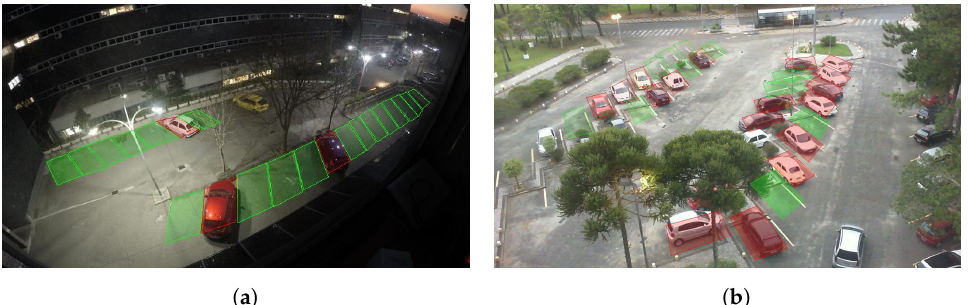
Figure 7. A sample of predictions obtained with the proposed multi-branch output system for two different datasets with different illumination and occupancy conditions. ( a ) Example of prediction for the ETSIT database with low lightning conditions; ( b ) example of prediction for the UFPR04 database with medium occupancy.